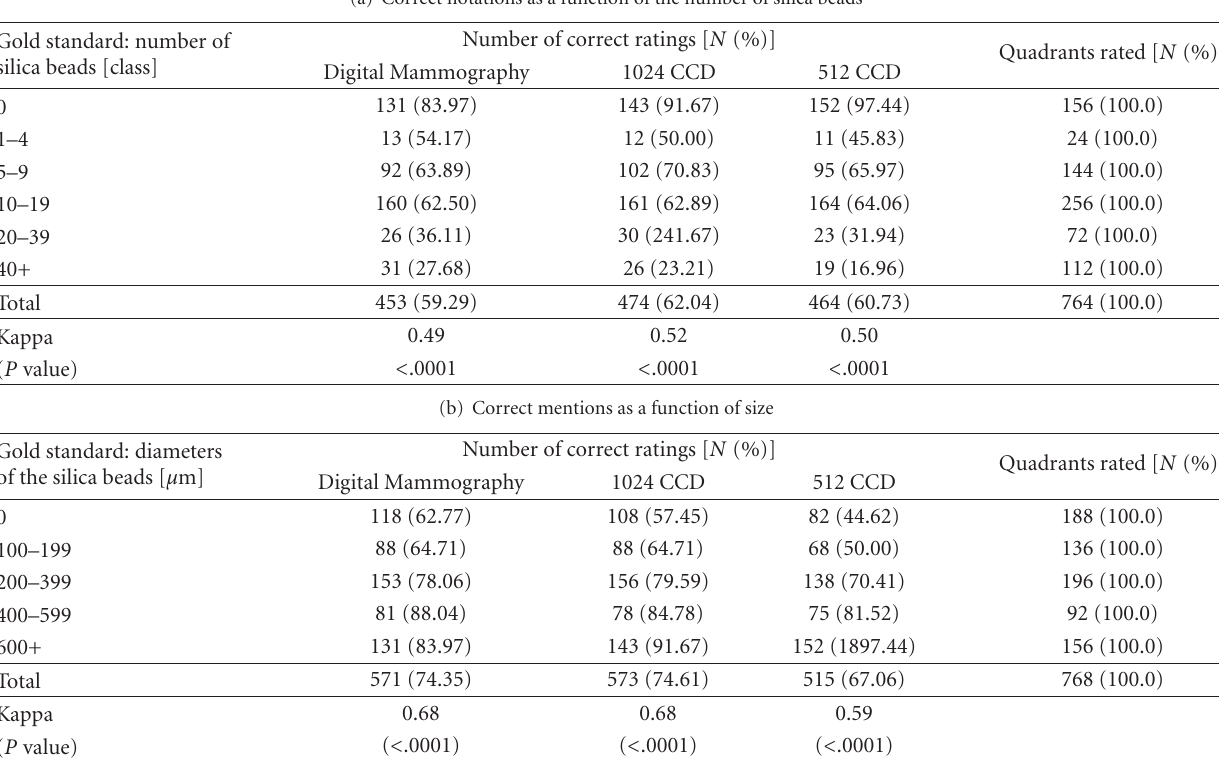
Table 1: Correct notations by the 4 raters for all quadrants on the 48 transparent films (768 observations per imaging technique). (a) Correct notations as a function of the number of silica beads